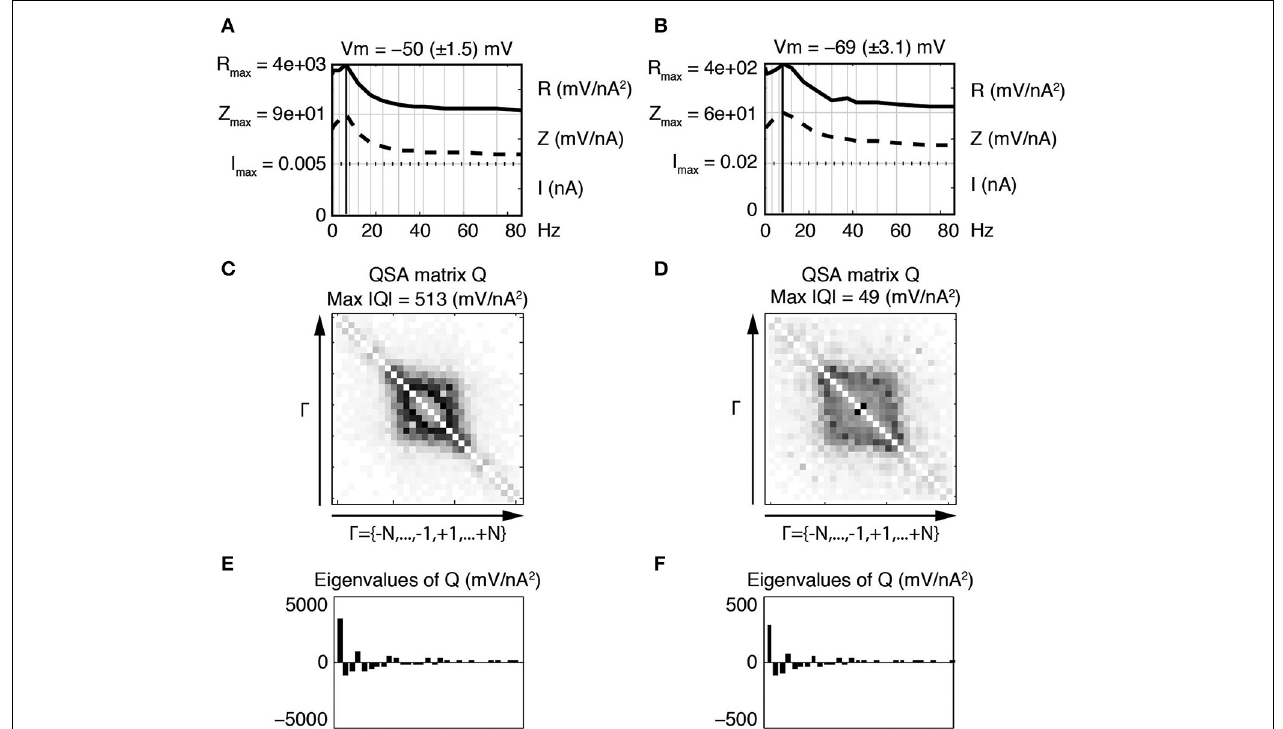
FIGURE 3 | Effect of the membrane potential level on linear and quadratic responses of a stellate neuron at − 50mV (left column) and − 69mV (right column). The standard deviation (STD) is indicated in parenthesis. The frequencies are indexed as f k where k ∈ (cid:3) = {− N ,..., − 1 , + 1 ,..., + N } and N = 15 denotes the number of stimulation frequencies. (A,B) Juxtaposed plots with respect to the input frequencies, namely the amplitudes of current stimulation I , linear impedance Z , and R function. A vertical bold line indicates the resonance frequency, which is f 4 = 6 . 4Hz for (A) and f 5 = 8 . 7Hz for (B) . The amplitude for each